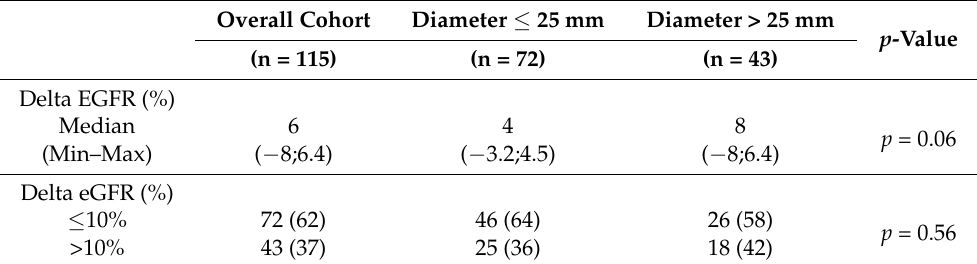
Table 3. eGFR variation between the two